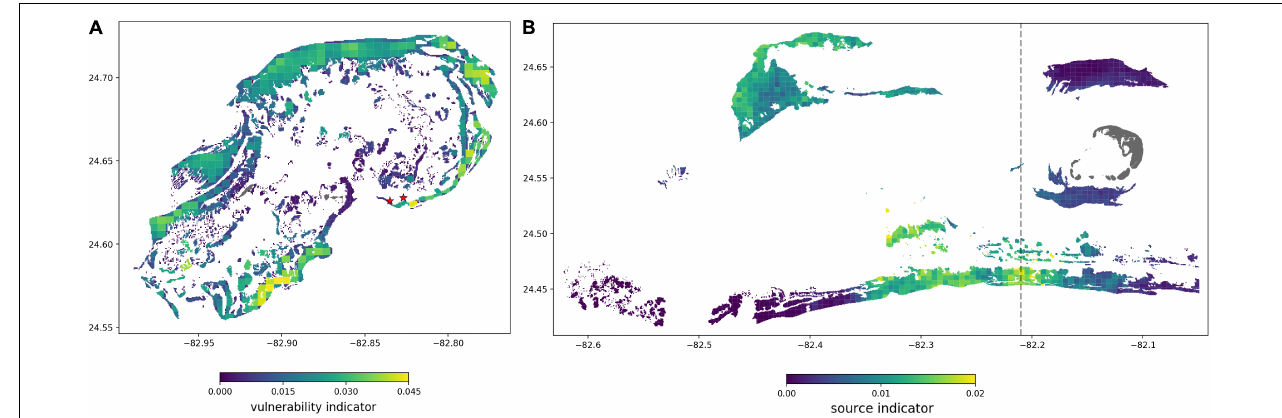
FIGURE 4 | (A) Vulnerability indicator value of all sub-reefs of the DRTO in November 2020. Eastern reefs of the DRTO appear most vulnerable to the disease. Locations where the SCTLD was observed in the DRTO are indicated by red stars. (B) Source indicator value in November 2020 for every sub-reef of the Marquesas and the Western Marquesas. Northwestern reefs of the Western Marquesas and southern reefs between the Marquesas and the Western Marquesas show a higher transmission potential to the DRTO. Main islands are shown in dark gray, separation between the Marquesas and the Western Marquesas is indicated by a dashed